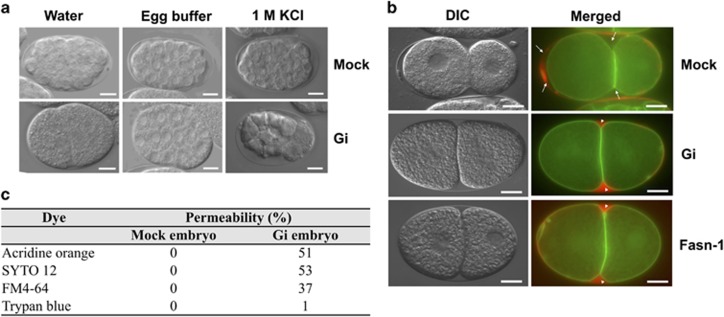
The impact of G6PD deficiency on C. elegans embryo physiology. (a) The effect of G6PD knockdown on C. elegans embryo morphology under physiological condition (Egg buffer) and osmotic stress (Water, KCl). Representative DIC images of embryos derived from Mock and G6PD(RNAi)(Gi) C. elegans are shown. White scale bar indicates 10 μm. (b) The effect of G6PD knockdown and fatty acid synthase knockdown (Fasn-1(RNAi)) on permeability barrier formation in C. elegans embryos. Representative DIC and merged fluorescent images of two-cell embryos derived from Mock, Gi and Fasn-1(RNAi) of OD344 C. elegans are shown. In Mock embryo, the permeability barrier prevented the diffusion of red fluorescence (mCherry::CPG-2) to the surface of embryos (white arrow). The permeability barrier was disrupted in Gi embryos. Such inhibition caused the mCherry::CPG-2 to fill the space between the eggshell and embryo surface (white arrow head). Green fluorescence indicates the plasma membrane of the embryo. White scale bar indicates 10 μm. (c) List of dye permeability ratio in Mock and Gi embryos with different dyes (n>100 embryos/group)